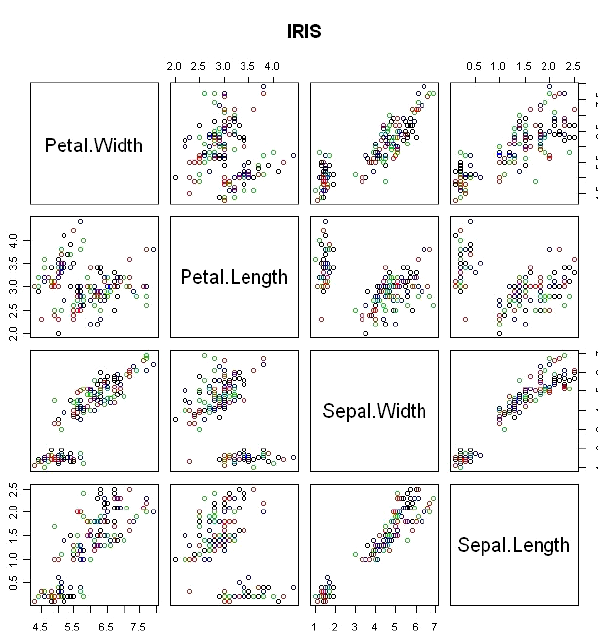
Fig. 14. 150 IRIS Dataset.